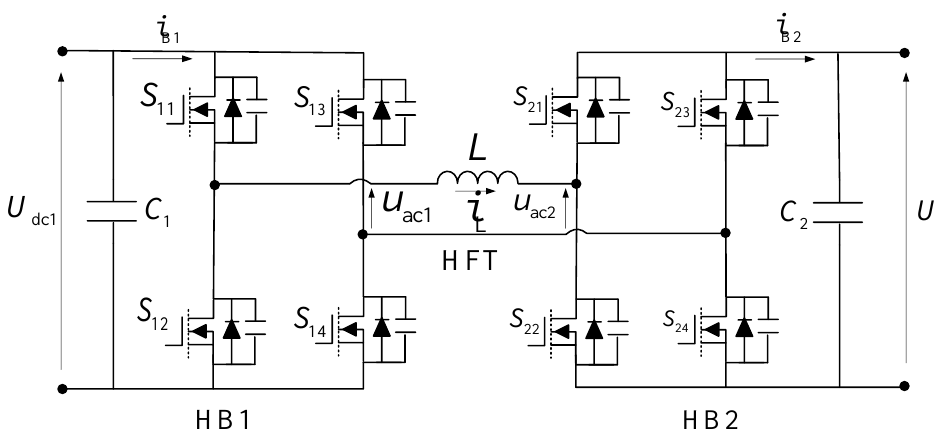
Figure 3. DAB approximate equivalent circuit.